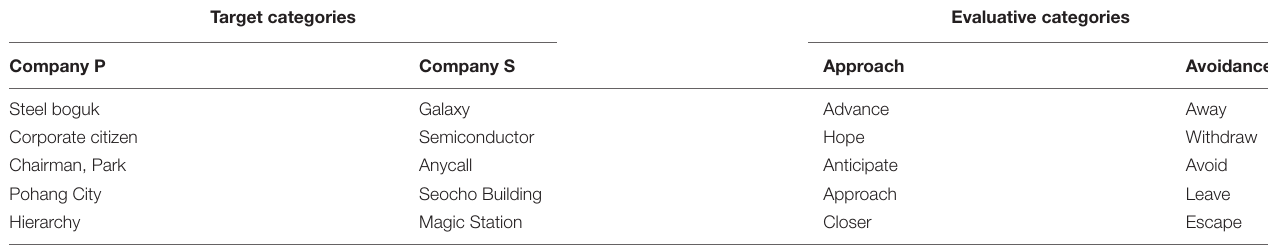
TABLE 2-1 | Procedure of IAT.